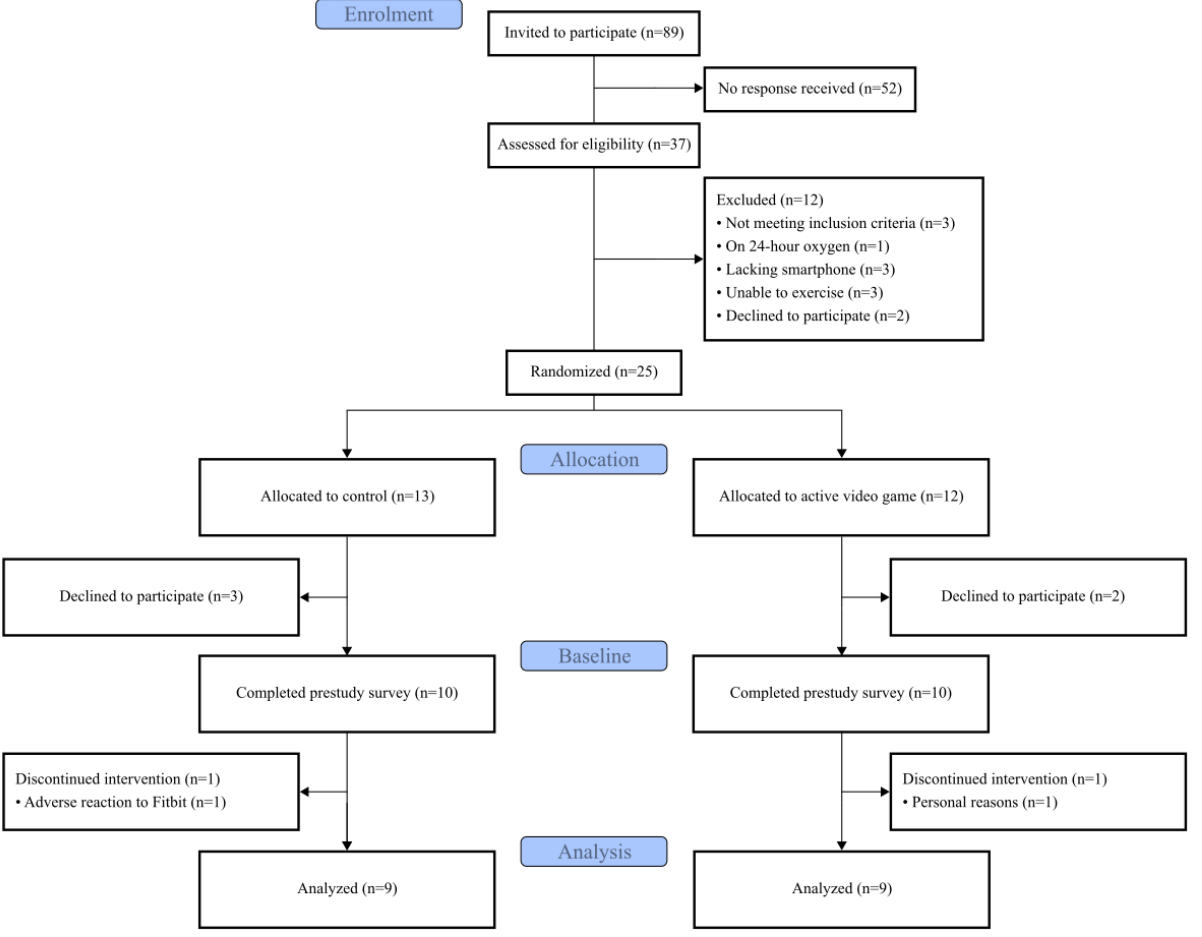
Figure 2. Consolidated Standards of Reporting Trials diagram showing the flow of participants through the study.